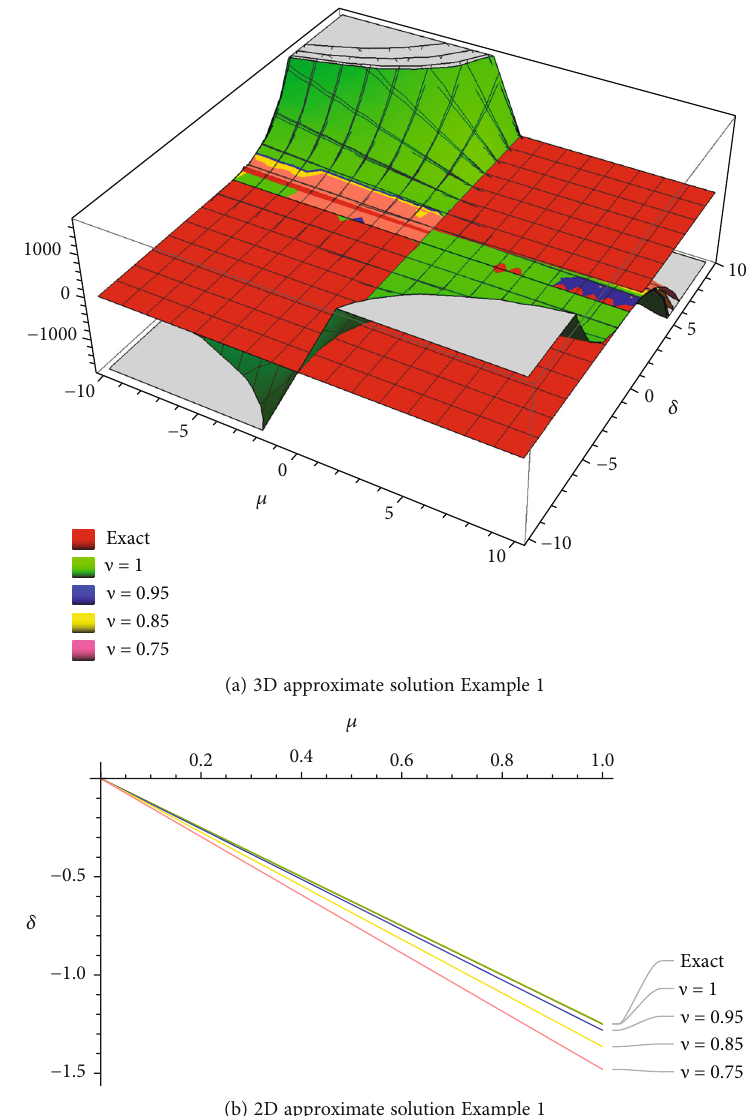
Figure 1: Create 2D and 3D comparison charts of precise data and predicted computational outputs for Example 1, using δ = 0 : 2